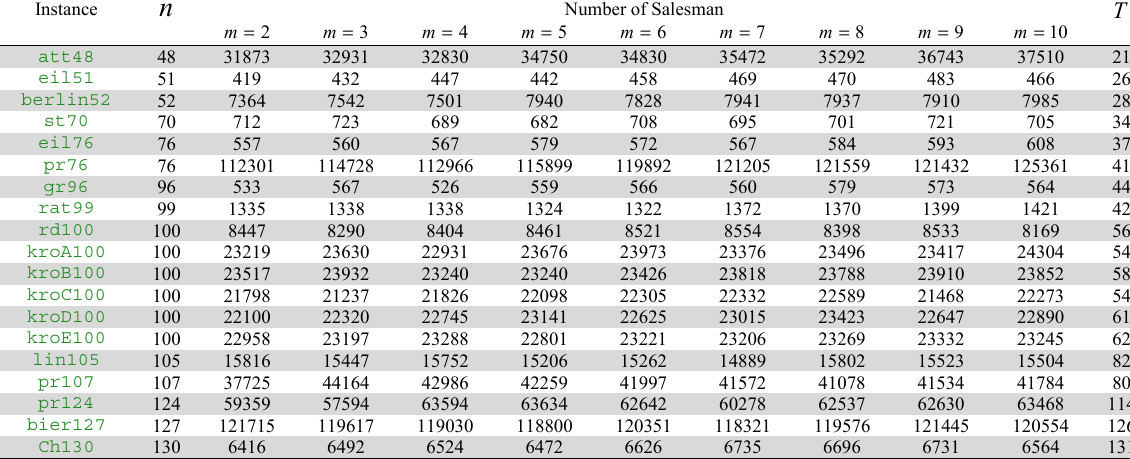
Computational results of